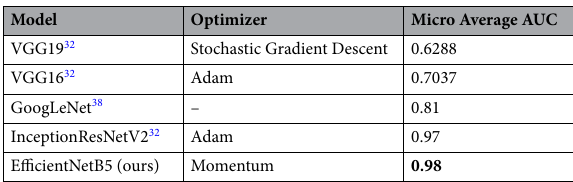
Table 2. ROC comparative results. The bold indicate to our results that used to comparative with other